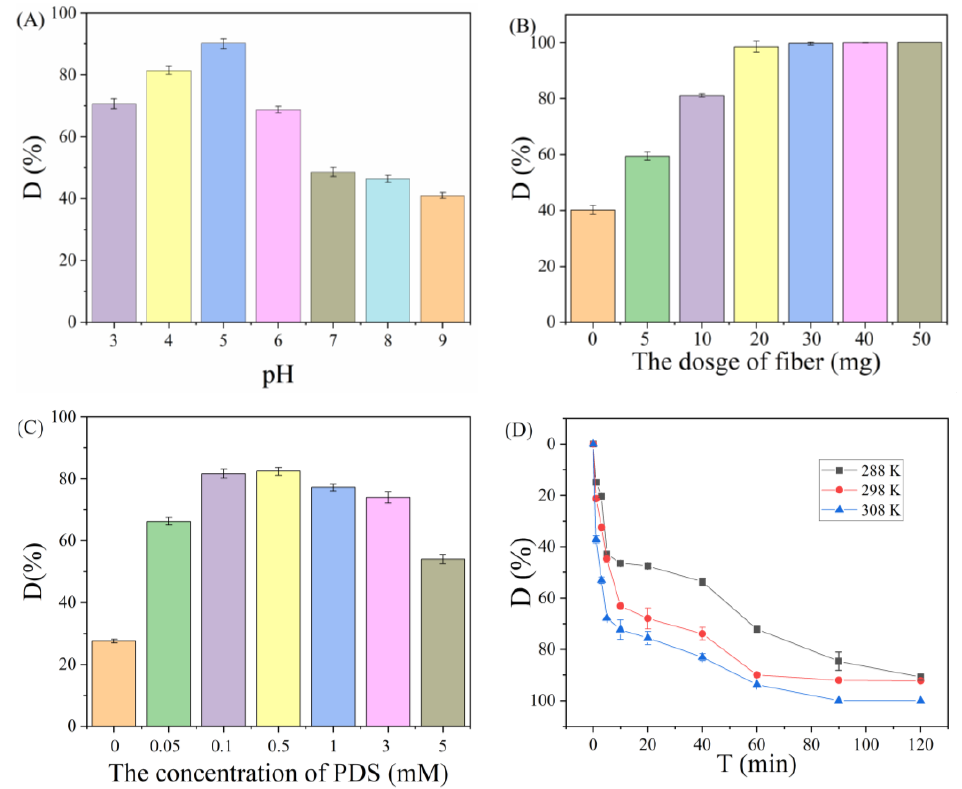
Figure 4. Influence of ( A ) pH, ( B ) fiber dosage, ( C ) PDS concentration, and ( D ) reaction time on PPOA